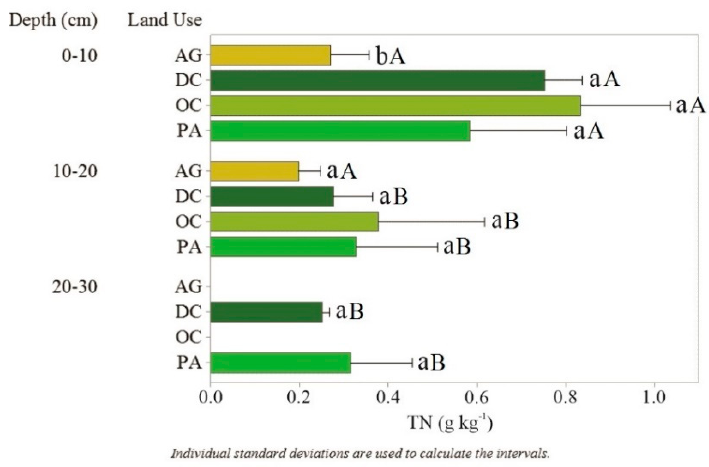
Figure 4. Total nitrogen (TN) content by layer under di ff erent types of land-use in the semi-arid region of Brazil. Note: equal lowercase letters mean no statistical di ff erence between land uses by the Kruskal–Wallis test ( p < 0.05) in the same layers. Di ff erent uppercase letters mean statistical di ff erences between layers for the same land-use layer by the Kruskal–Wallis test ( p <